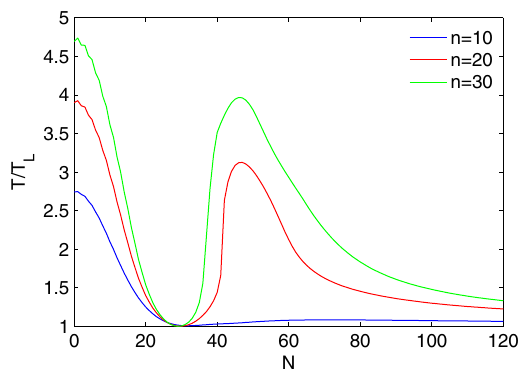
FIG. 11. Simulation results of the energy modulation ampli- tude and corresponding local bunching factor distributions along the electron beam for different harmonics of the seed ( n ¼ 1 , 6, and 10).